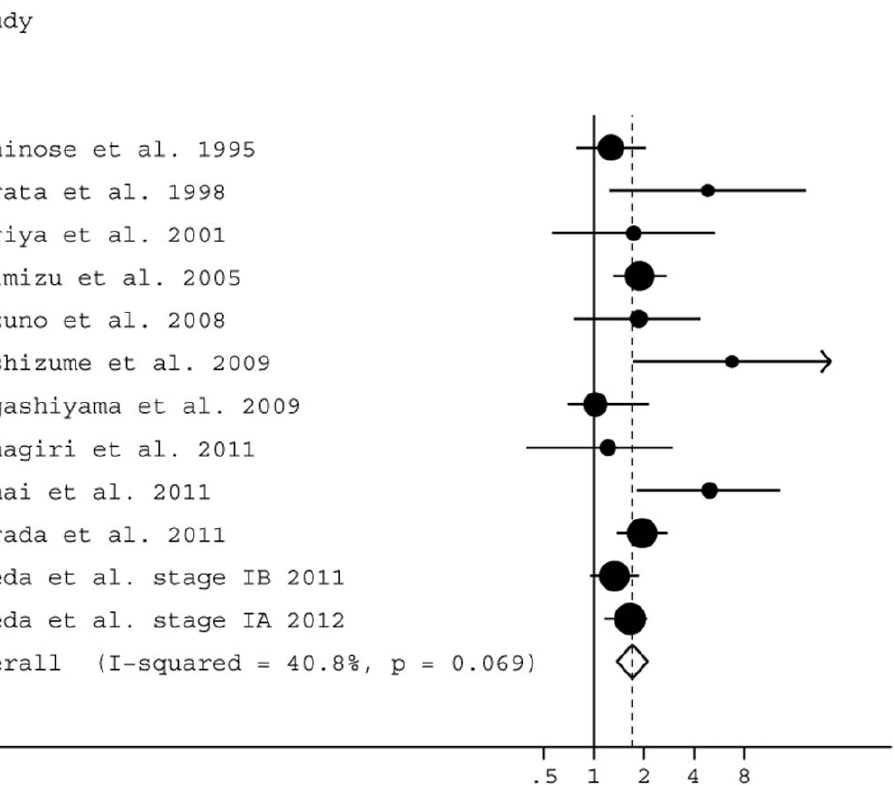
Figure 4. Forest plot showing the combined relative hazard ratio for overall survival of stage I patients by multivariate analysis.